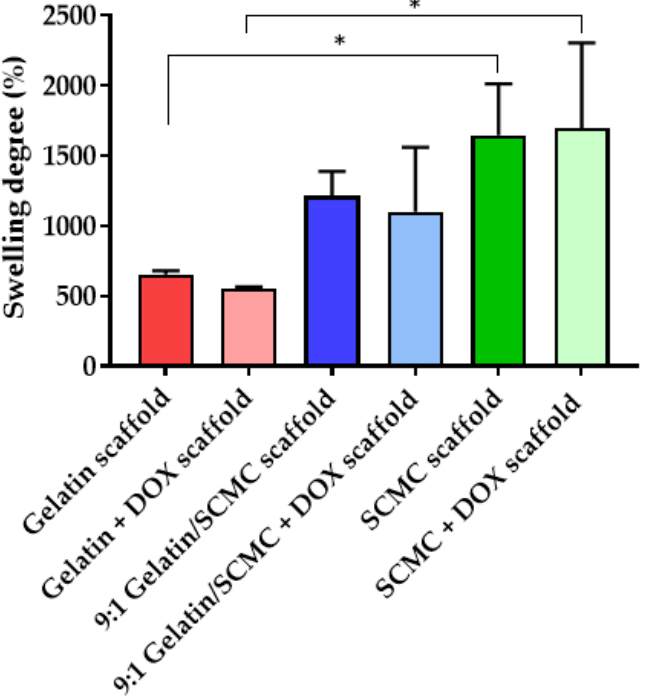
Figure 5. Swelling index (%) of gelatin, 9:1 gelatin/SCMC, and SCMC scaffolds with and without DOX. Data are expressed as mean ± S.D., * indicated p < 0.05.